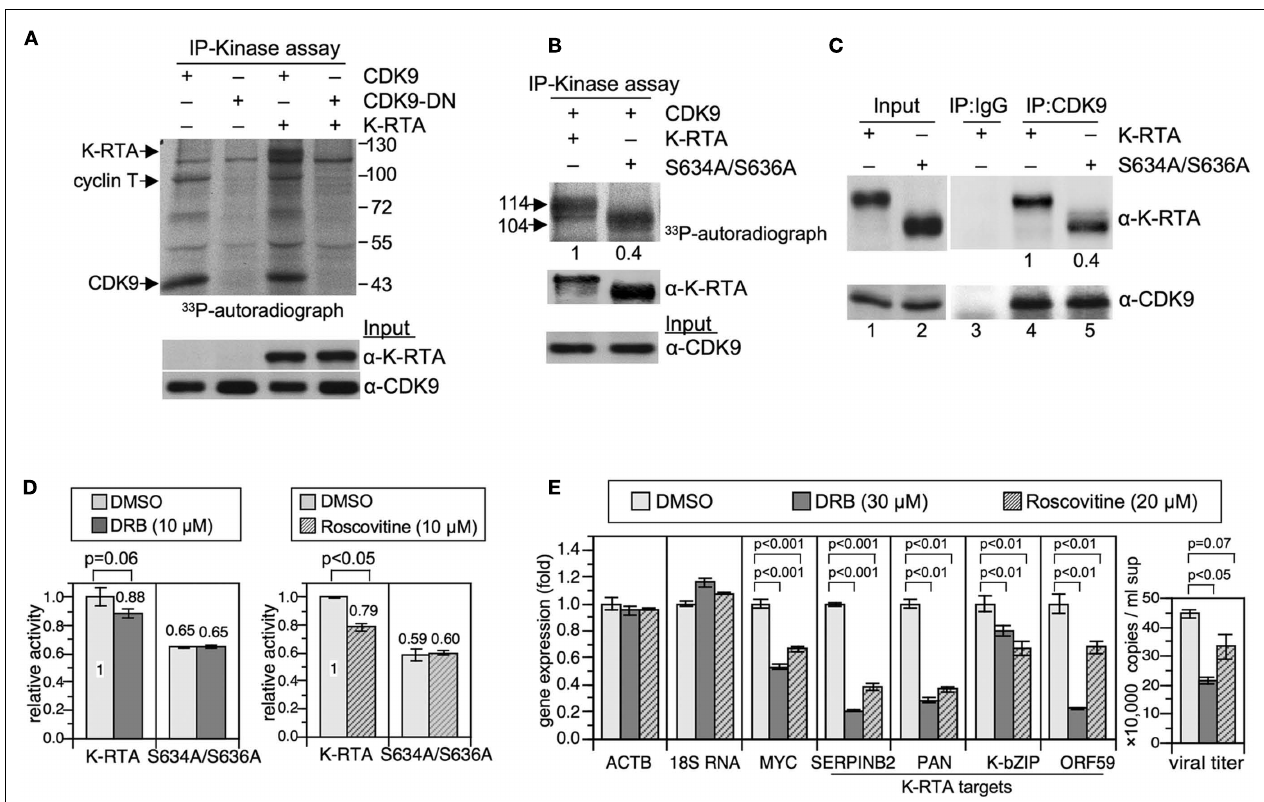
transactivation of PAN promoter were determined by a luciferase reporter assay. HEK293 cells were cotransfected with plasmids expressing K-RTA or S634A/S636A together with PANp-driven luciferase reporter plasmid for 6h, followed by inhibitor treatments for 18h. Each firefly luciferase value was normalized to an internal control plasmid phRL-TK.The normalized value of the untreated group in K-RTA was set to 1. Data are presented as the means ± SD for quadruplicate transfections. Similar pattern was observed in two independent experiments. One set of data is shown. Statistical evaluations were performed with Student’s t -test. (E) (Left) quantitative RT-PCR analysis for gene expressions of β -actin (ACTB), 18S ribosomal RNA (18S RNA), known RNA Pol II pausing gene (MYC), and K-RTA target genes (cellular SERPINB2, KSHV PAN, K-bZIP, ORF59) in K-RTA expressing 293/rKSHV.219 cells treated with indicated inhibitors for 42h. GADPH-normalized RNA value was quantified as fold change over the DMSO group. Statistical evaluations were performed by using Student’s t -test. (Right) KSHV viral particles released in the culture media from each treated groups were determined by comparative quantitative PCR of KSHV ORF9, as described in Figure 3D. Data are presented as means ± SD for three PCR assays in an experiment. Similar results were obtained from two independent experiments; one set of data is